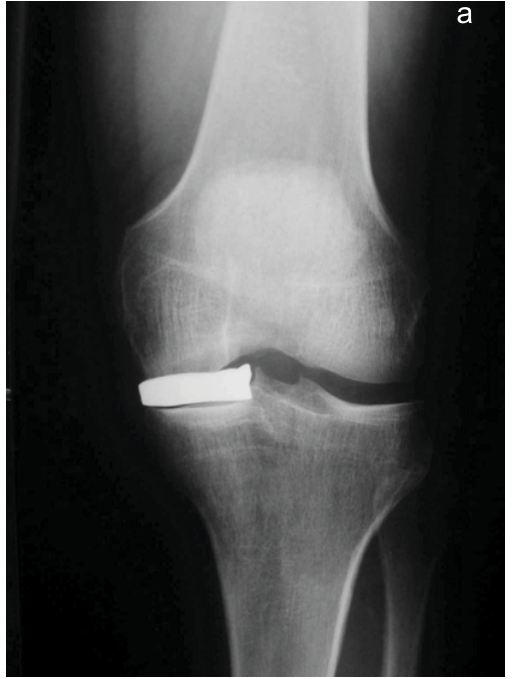
Figure 2. (a) a.p. x-ray 12 months post iForma re-implantation; (b) Lateral x-ray 12 months post iForma